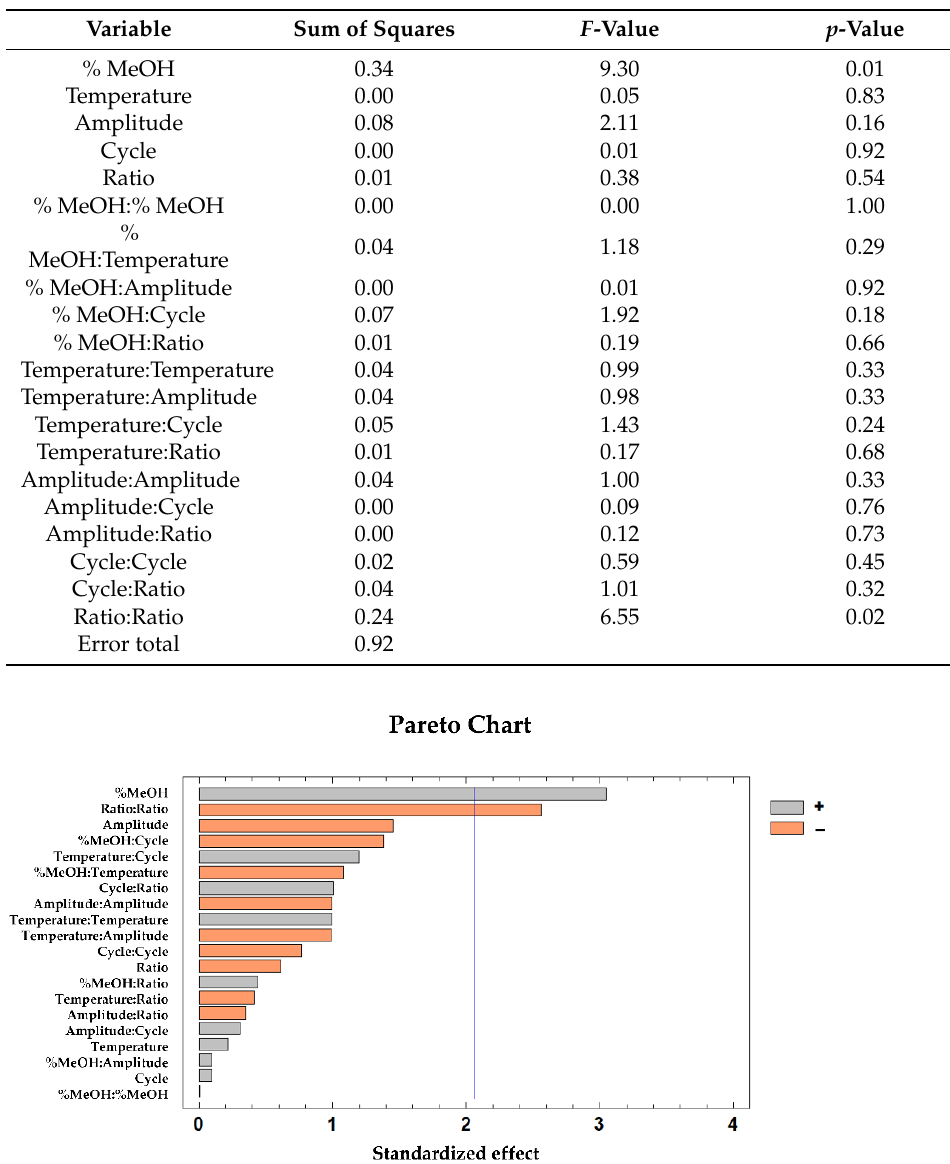
Table 2. Results from the BBD–RSM for Antioxidant Activity (DPPH).